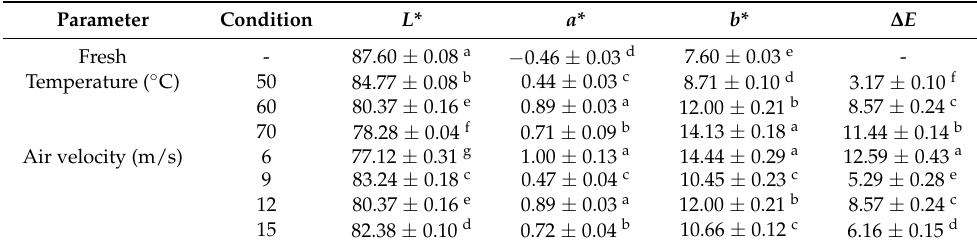
Table 2. Color parameters of raw and dried Ophiopogonis Radix